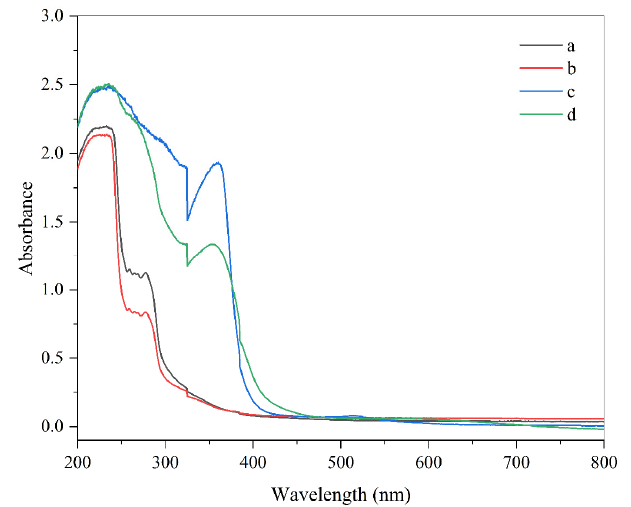
Figure 1. Absorbance spectrum of ( a ) gelatin, ( b ) gelatin/chitosan nanofibers, ( c ) G/CsNFs/Bas, and ( d ) G/CsNFs/SPAs films. ( d ) G/CsNFs/SPAs